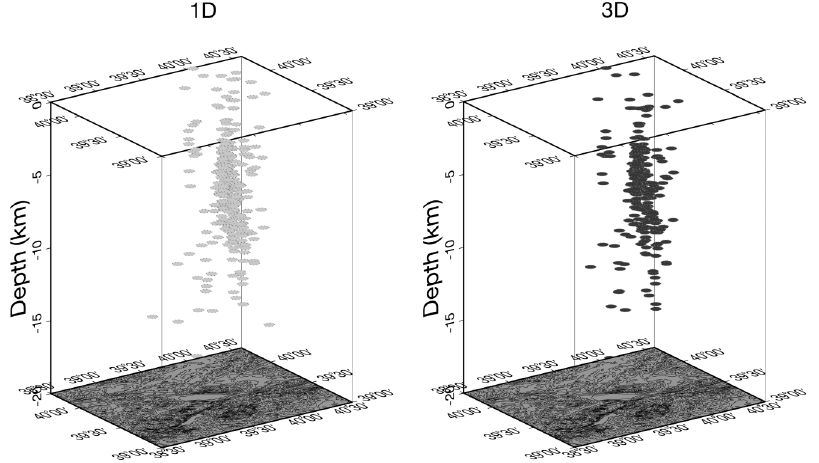
Fig. 12. 3D perspective views of the events relocated using a 1D velocity starting model ( left ) and a 3D final heterogeneous velocity model ( right ). A topographic map of the region is shown at the